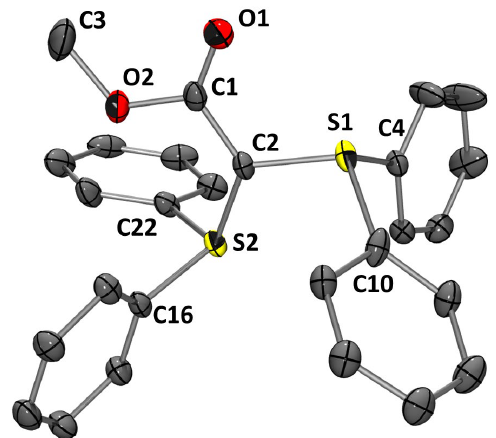
Figure 3. Cationic part of 6 . Ellipsoids are drawn at the 30% probability level; hydrogen and disordered atoms and counter ion (I − ) are omitted for clarity. Selected bond lengths (Å) and angles (°):